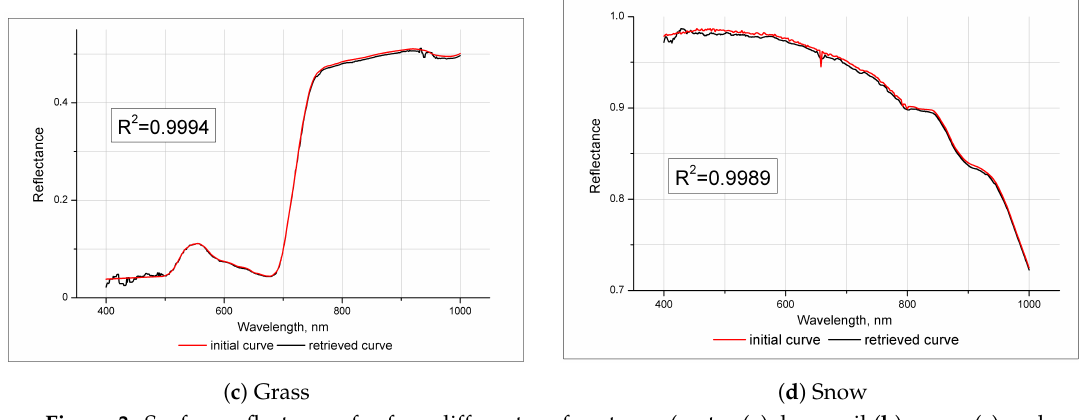
Figure 3. Surface reflectances for four different surface types (water ( a ), bare soil ( b ), grass ( c ) and snow ( d ) retrieved by SHARC technique using the numerically calculated (LibRadTran) outgoing TOA radiance spectra, compared to the surface reflectance spectra, initially given in direct problem.